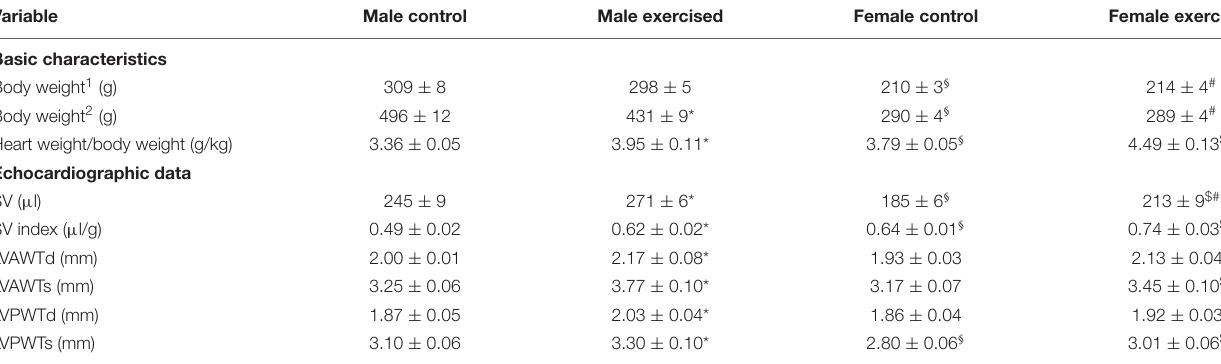
TABLE 1 | The echocardiographic data of the experimental groups.